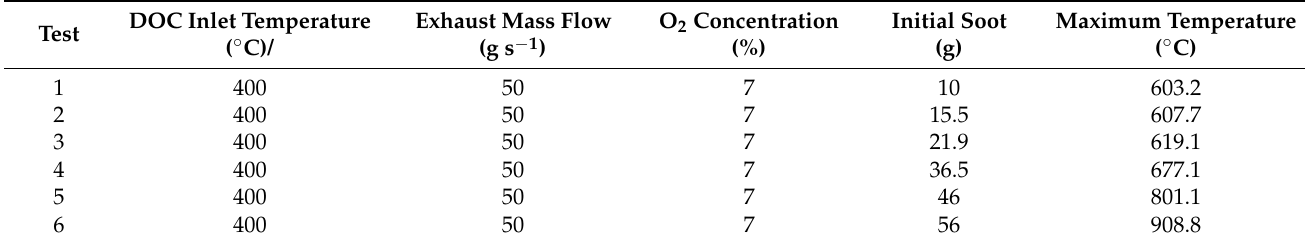
Figure 12. The DPF regeneration temperature distribution with different initial soot loading quantity. ( a ). 10 g ( b ). 15.5 g ( c ). 21.9 g ( d ). 36.5 g ( e ). 46 g ( f ). 56 g. Table 7. Maximum DPF inner temperature with different initial soot loading